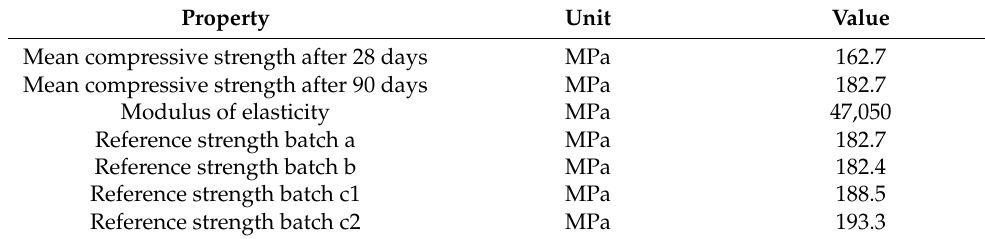
Table 1. Material properties of